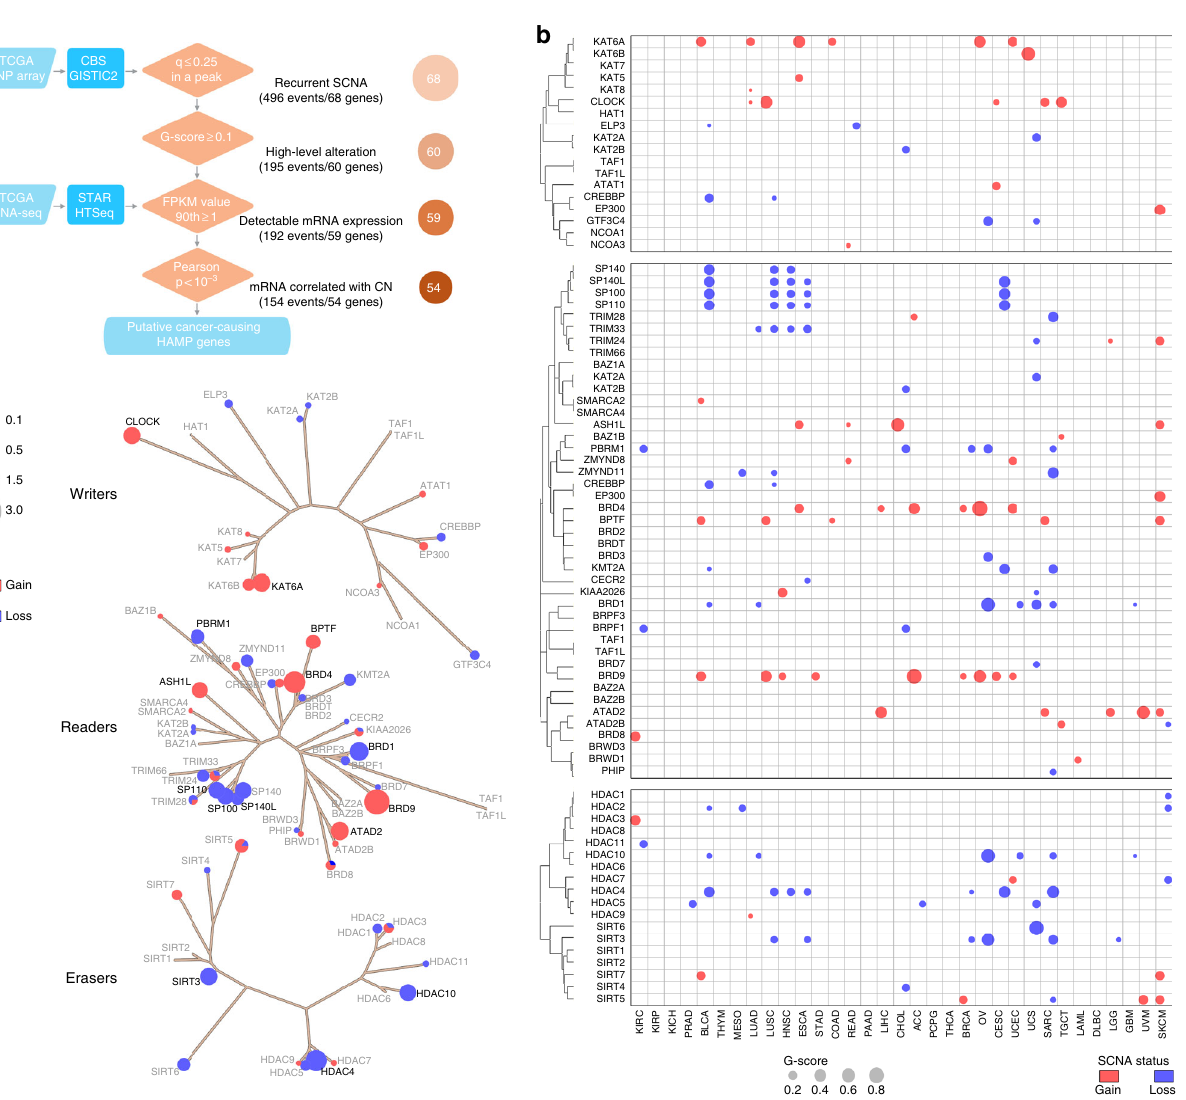
Fig. 2 Somatic copy number alterations of HAMPs across cancers. a The work fl ow of somatic copy number alteration analysis. Four criteria were used to identify the putative cancer-causing HAMPs driven by SCNAs in each cancer type. The numbers of HAMPs that passed each fi lter in at least one cancer type are shown on the right. b The bubble plot shows the G-scores, which consider both the amplitudes of the aberrations and the frequencies of their occurrence across samples, of the putative cancer-causing HAMPs driven by SCNAs in each cancer type. The size of the bubble: G-score; red: gain; blue: loss. The phylogenetic trees were generated by multiple sequence alignments of the full-length sequences of the proteins. c Summary of the overall G-scores of the putative cancer-causing HAMPs driven by SCNAs, which were identi fi ed in at least one cancer type. The size of the bubble: the overall G-score; red: gain; blue: loss. The HAMPs coding in black and gray indicate a gene with an overall G-score ≥ 0.8 and < 0.8, respectively. The phylogenetic trees were generated by multiple sequence alignments of the full-length sequences of the